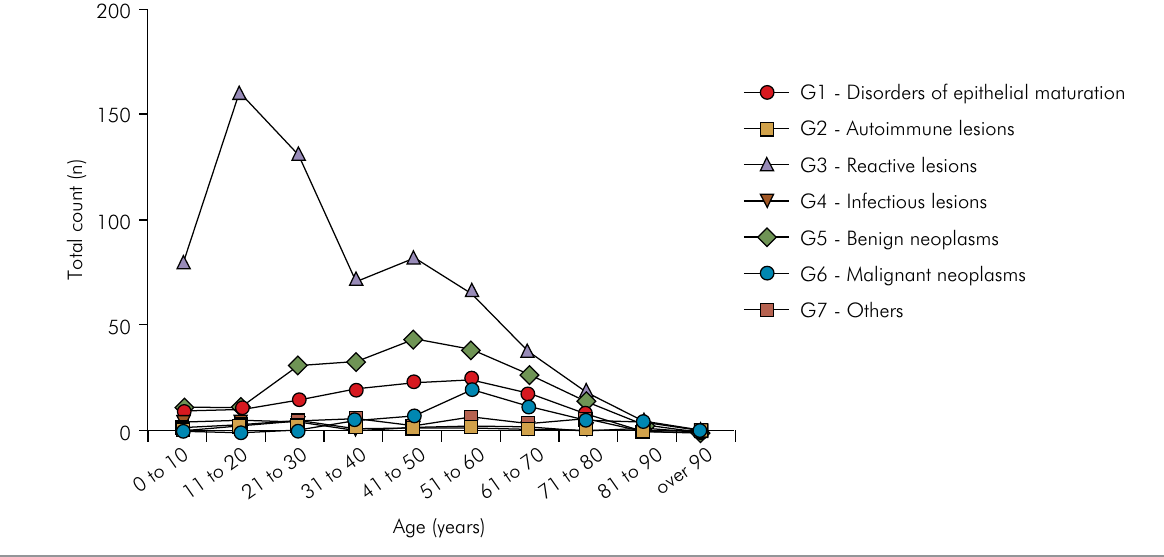
Figure 1. Distribution of all lip lesions (n = 1195) according to type and